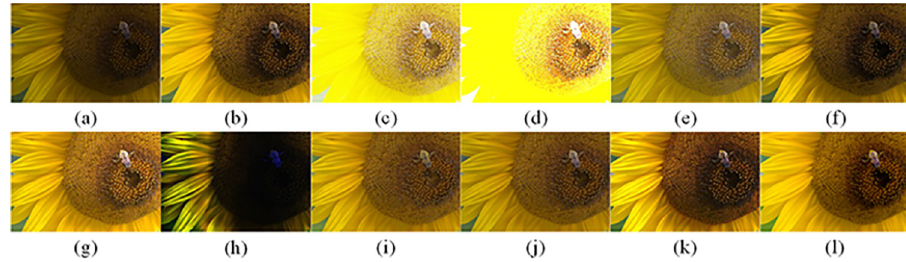
Fig 11. Comparisons of the ten algorithms in enhancing low-light image 1. (a) low-light image (b) AGCWD (c) Al- Ameen (d) BHE2PL (e) BIMEF (f) BPDHE (g) LIME (h) MSRCR (i) NPEA (j) SRIE (k) OURS (l) Normal light image.